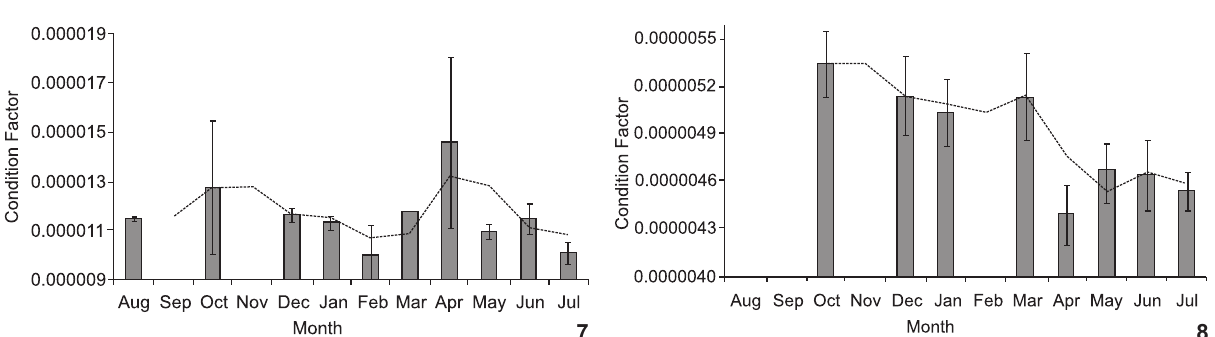
Figures 7-8. Monthly condition factor + standard error and respective trend slopes (dashed line) for S. herzbergii females (7) and males (8) in Paraíba do Norte River Estuary, Brazil.